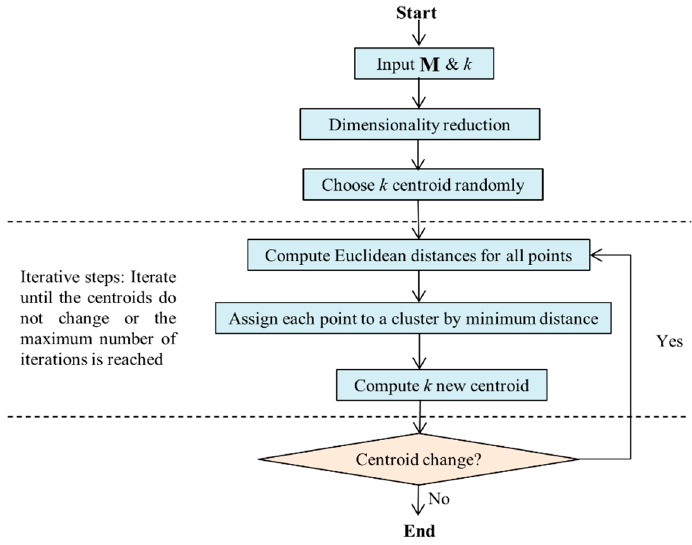
Figure 10. Flowchart of the algorithm for data partition.